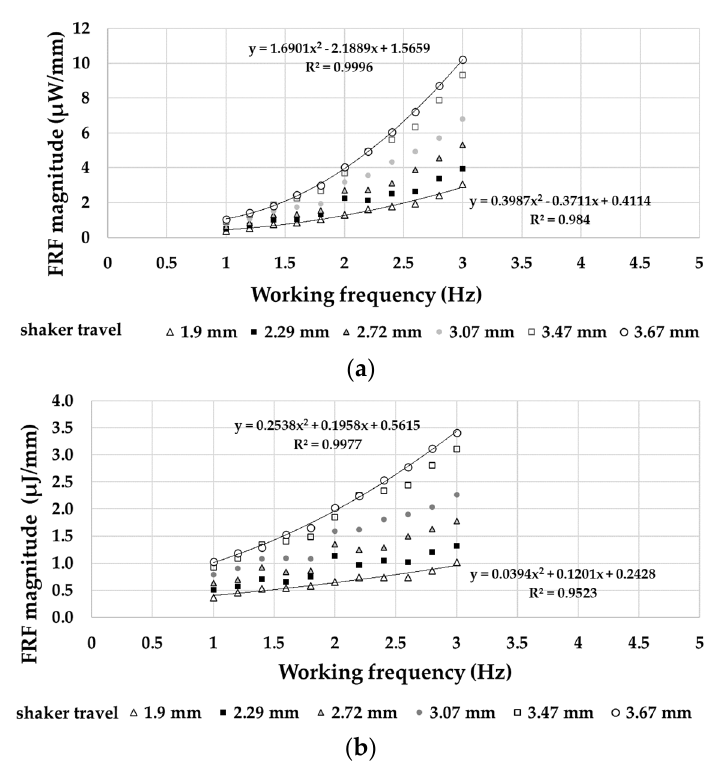
Figure 17. ( a ) Power/linear displacement ratio frequency response functions (FRF) and ( b ) En- ergy/linear displacement ratio FRF.